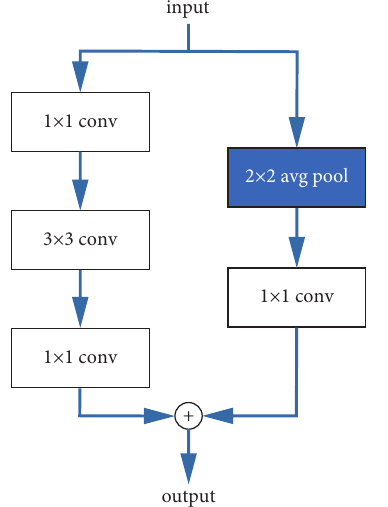
Figure 4: Downsampling block tweak of ResNet-D.